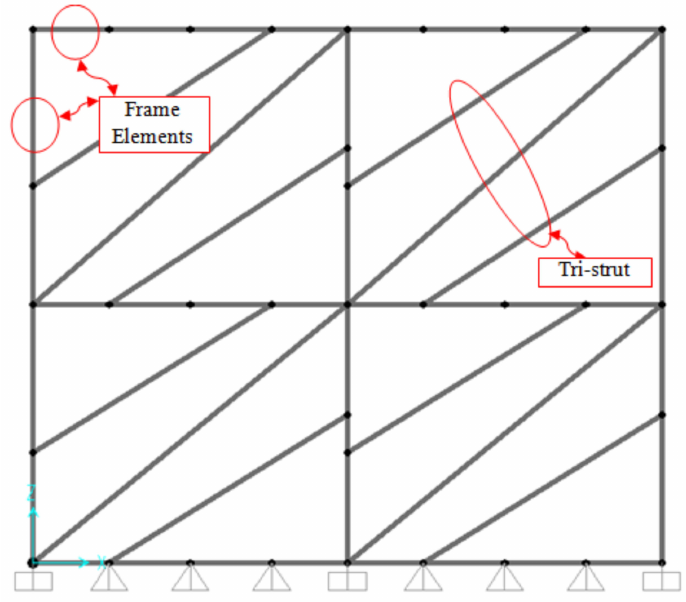
Figure 8. Schematic representation of Tri-strut Finite Element Model of H-building structure.